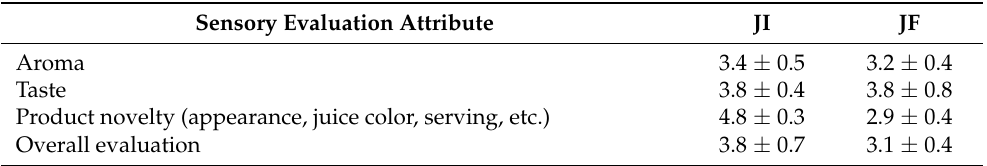
Table 2. Sensory evaluation of novel juice products fortified with free or immobilized freeze-dried L. rhamnosus OLXAL-1 cells. Sensory Evaluation Attribute